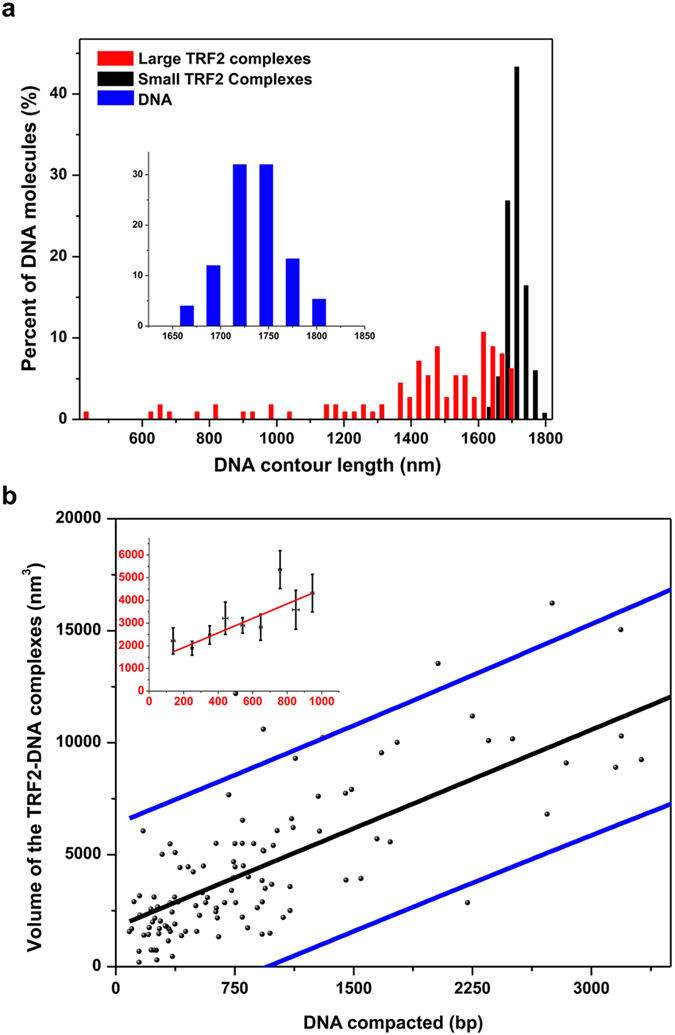
The extent of DNA compaction by large TRF2 complexes correlates with the volume of the complexes.(a) Histograms of the length of DNA alone (insert, blue bars, N = 69, 1721.0 ± 61.9 nm), DNA with small (black bars, N = 134, 1704.0 ± 59.0 nm) and large (red bars, N = 51, 1532.0 ± 241.0 nm) TRF2 protein complexes. (b) Quantification of the relationship between the amount of DNA compacted inside TRF2 proteins and corresponding AFM volume. The black line: the linear fit, blue lines: lower and upper bounds of the 95% prediction limit for the fit. The linear fit for this data (R2 = 0.52): V = 1766 + 2.9 Lc. The insert is a plot from averaging the volume of TRF2 complexes in each compacted DNA length window (100 bp). The error bars represent standard deviations. The red line is the fitting of the data (R2 = 0.68): V = 1284 + 3.2 Lc, where V is the volume of the TRF2 complex and Lc is the DNA length compacted inside TRF2 complexes in base pairs.